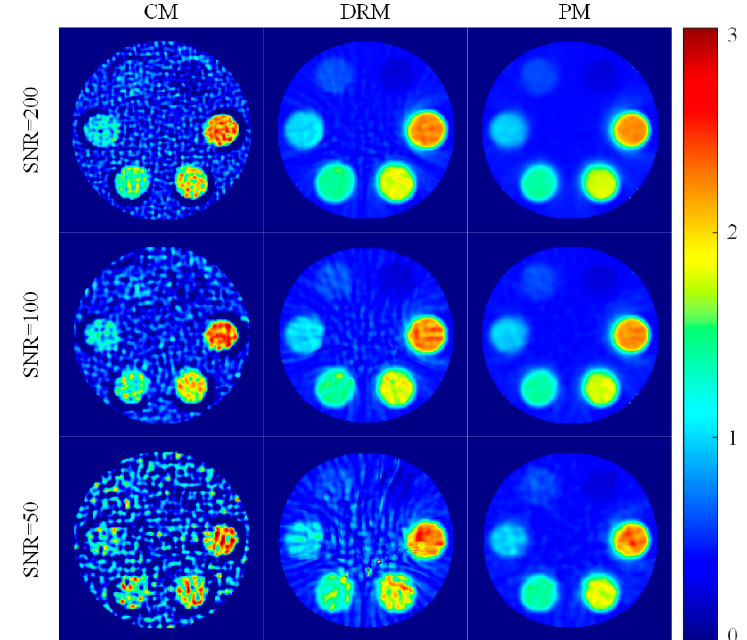
Figure 4. Reconstructed conductivity images under different noisy transceive phase data using the conventional method (CM), double regularization method (DRM), and the proposed method (PM).